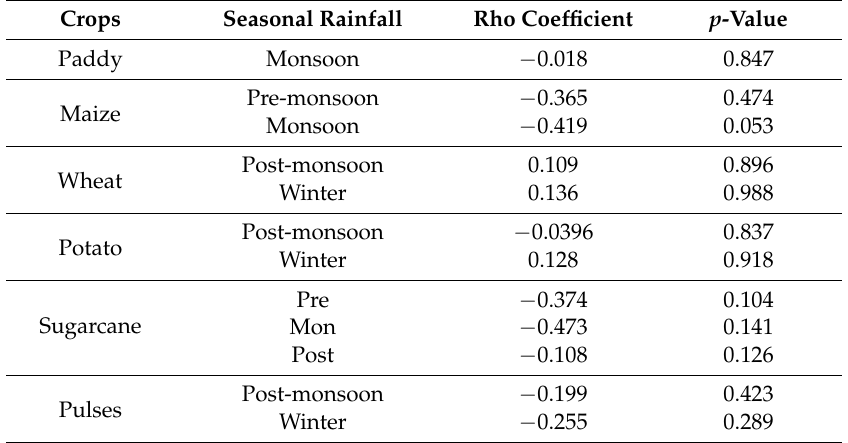
Table 12. Spearman’s rank correlation test results for the yield of major crops with seasonal rainfall.